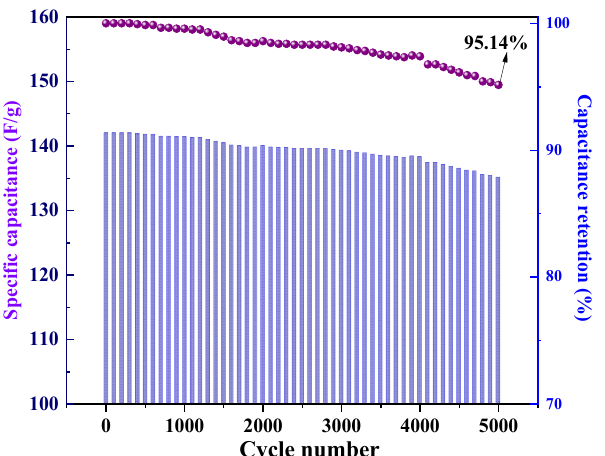
Figure 11. Specific capacitance and capacitance retention of SNC700 electrode material for 5000 cycles.